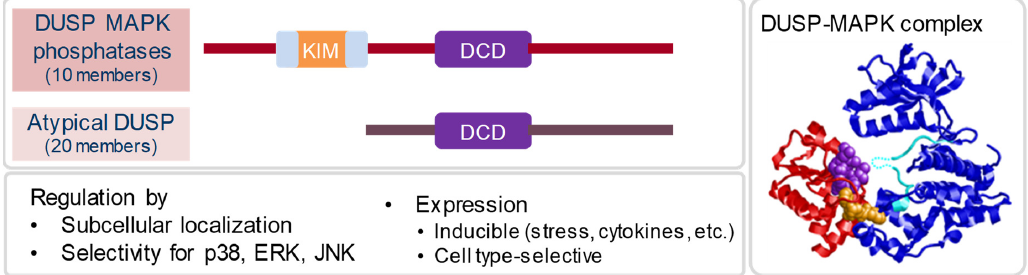
Figure 1. Dual-specificity phosphatases (DUSP): domain structure, mode of action, and levels of regulation. The 10 members of the classical DUSP-MAPK phosphatases contain a MAPK-binding kinase-interaction motif (KIM) conferring selective binding to ERK1 / 2, p38 or JNK1 / 2. Upon binding to MAPK, the DUSP catalytic domain (DCD) dephosphorylates the TXY motif in the activation loop (right panel). Atypical DUSPs lack a KIM and can have more diverse substrates, including phosphorylated RNA (DUSP11). Regulated expression between cell types and after stimulation, different compartmentalization of DUSP, and selectivity in binding to MAPK family members confers specificity of DUSP action in signaling.